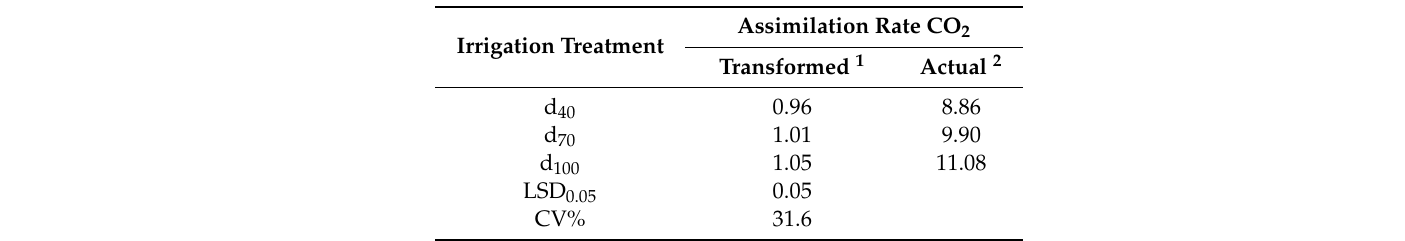
Table 6. Main effect of Irrigation levels on Assimilation rate CO 2 . Data presented are mean values, where LSD is the least significant difference at the 0.05 significance